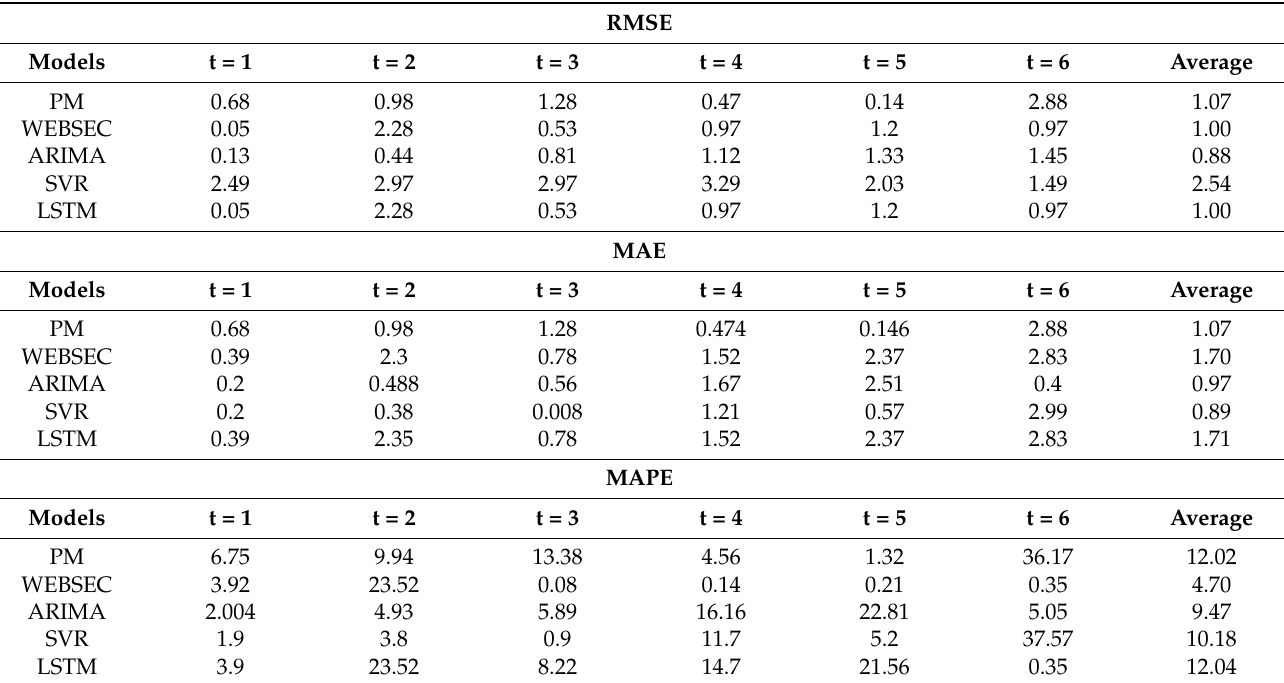
Table 6. Performance results of different univariate WSP models for South Plains TX region. RMSE